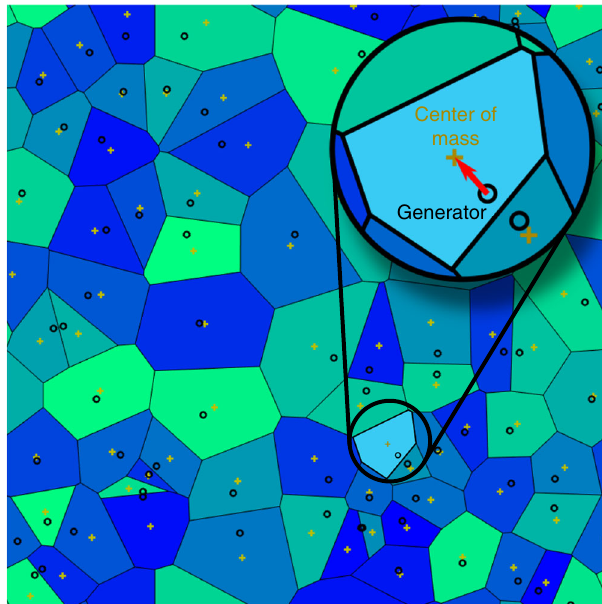
Fig. 1 Schematic representation of a Lloyd iteration. Lloyd iterations convert an initial point set to a point set with a centroidal Voronoi diagram. In each iteration, the algorithm fi rst computes the Voronoi cells for all points. Then each point (black circle) is replaced by the centre of mass (yellow cross) of